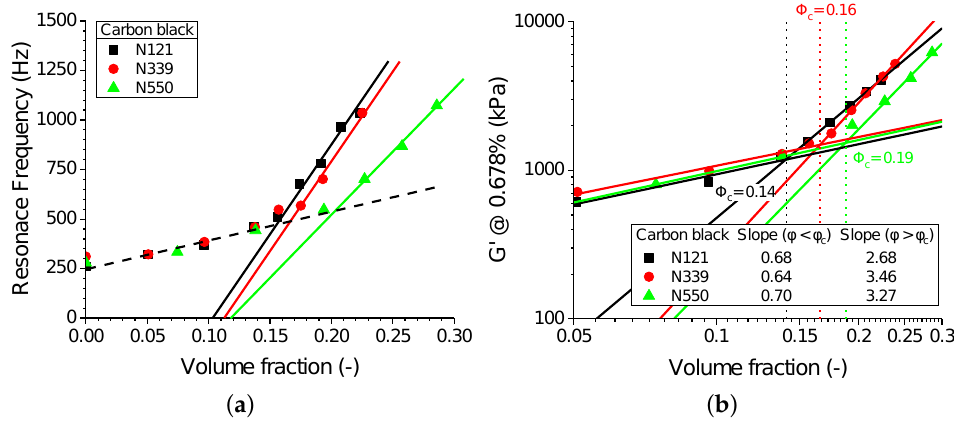
Figure 3. The ( a ) resonance frequency and ( b ) the corresponding storage modulus at low strain of the solution-polymerized styrene-butadiene rubber (SSBR) compounds, as described in Table 1. The dotted lines in ( b ) indicate the corresponding percolation thresholds obtained by RPA